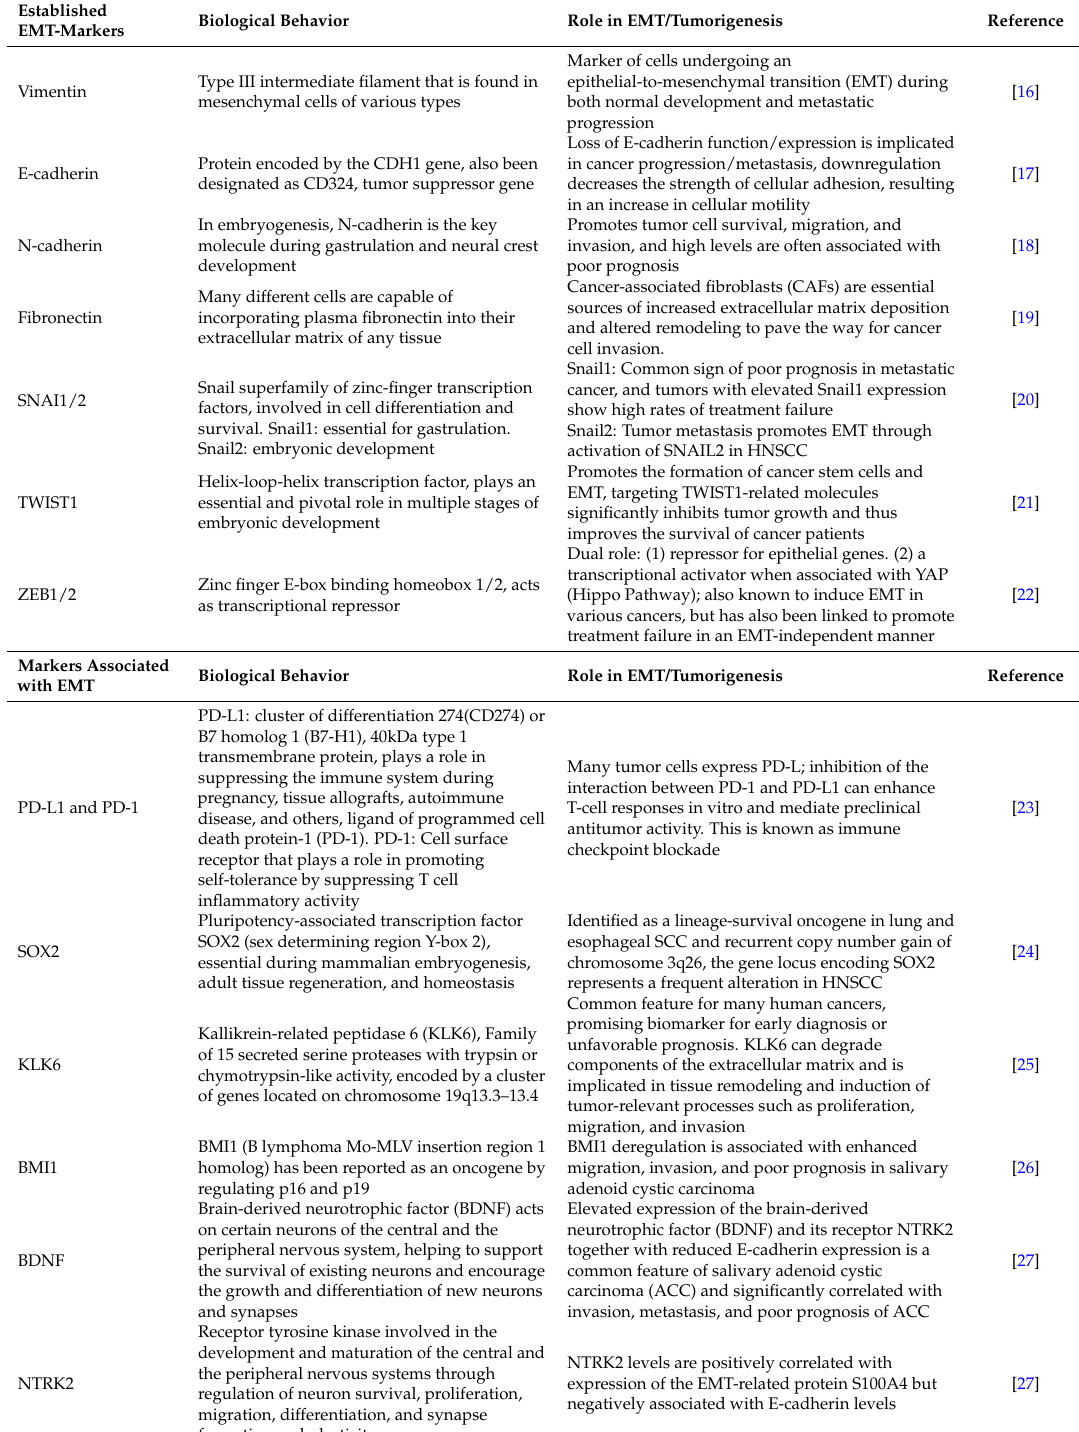
Table 1. Expression of different molecules and their participation in biological behavior and epithelial-to-mesenchymal transition (EMT). HNSCC: Head and neck squamous cell